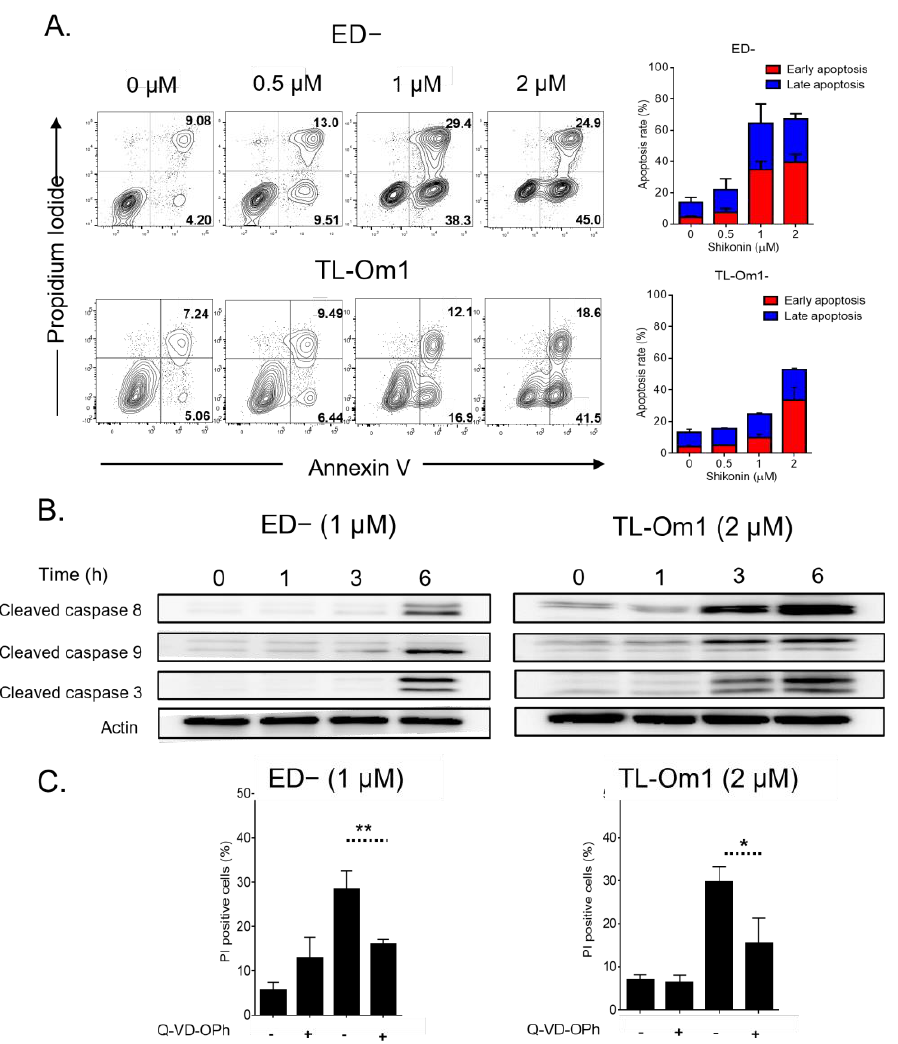
Figure 2. Induction of caspase-dependent apoptosis in ATLL cells by SHK. ( A ) Human ED − and TL-Om1 cells were treated with/without SHK for 18 h (0, 0.5, 1 and 2 µ M). Cells were stained with annexin V and PI. Apoptosis was measured using flow cytometry. ( B ) Human ED − and TL-Om1 cells were treated with or without SHK for 18 h (1 and 2 µ M), respectively. Apoptosis markers were analyzed by Western blotting. ( C ) Human ED − and TL-Om1 cells were pre-treated with Q-VD-OPh in a concentration of 20 µ M for 2 h, and then with or without SHK (1 and 2 µ M) for 18 h. Cell death was measured by PI staining and flow cytometry. *p<0.05, **p<0.01.